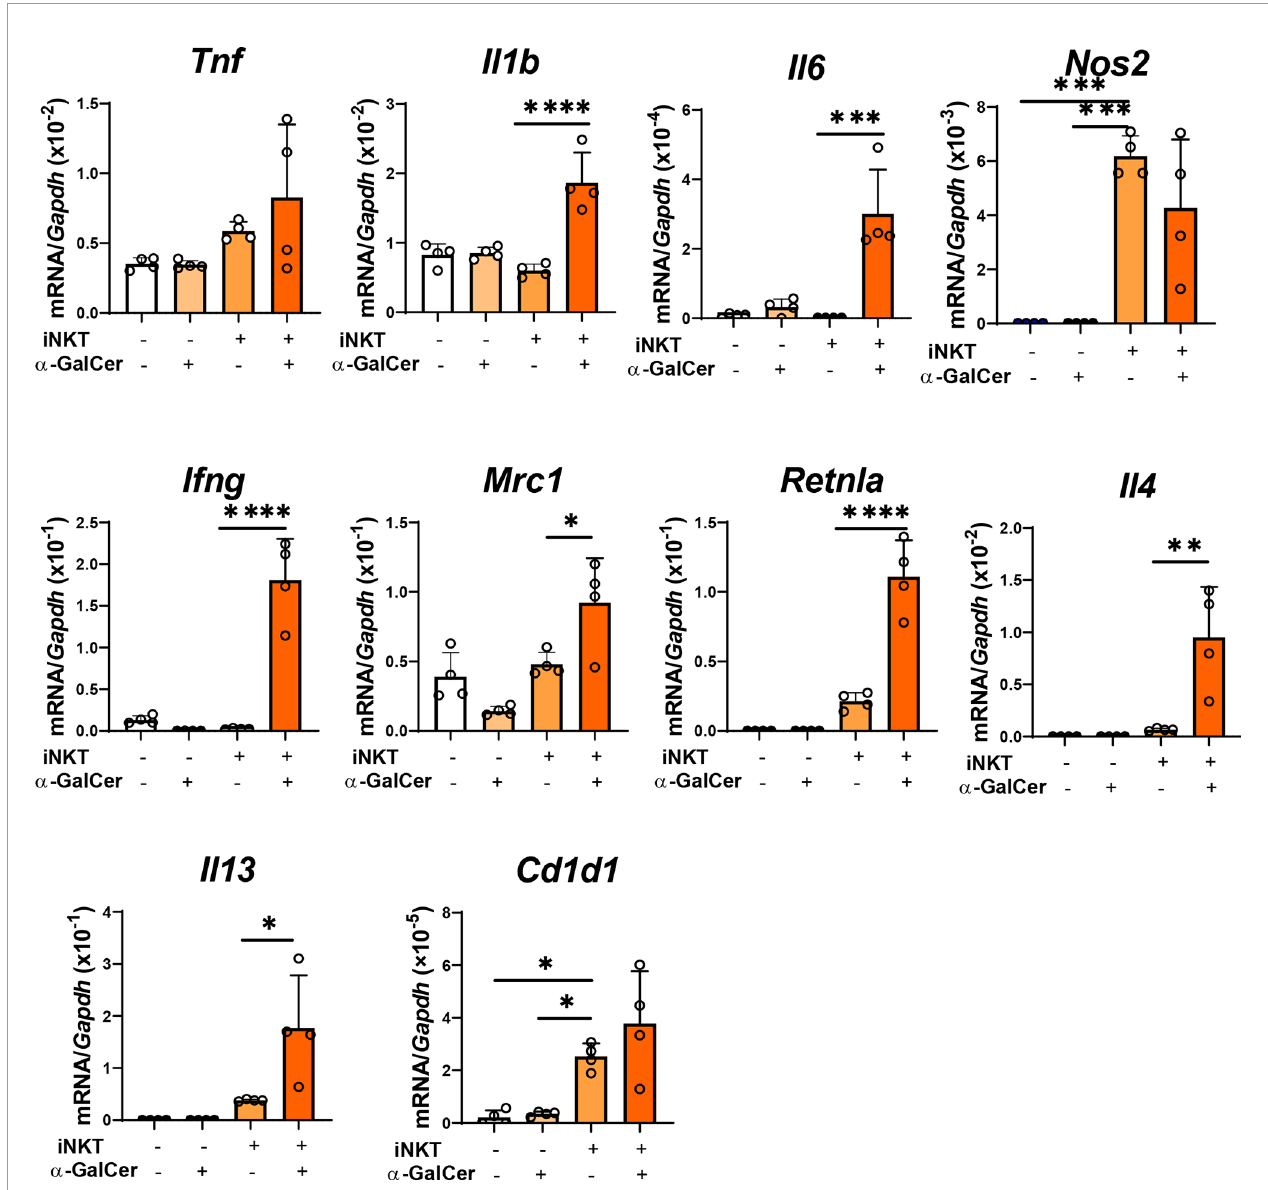
FIGURE 5 | Activated iNKT cells made cultured macrophages differentiate in both ways. The levels of mRNA encoding genes related to a pro-in fl ammatory macrophage phenotype ( Tnf, Il1b, Il6, Nos2, and Ifng ), genes related to a reparative macrophage phenotype ( Mrc1, Retnla, Il4, and Il13 ), and Cd1d in macrophages co-cultured with iNKT cells. Macrophages were cultured alone, in the presence of a -GalCer, or with isolated hepatic iNKT cells, or isolated hepatic iNKT cells and a -GalCer for 72 h. Data are expressed as the mean ± SD (four mice per group, representative data from two independent replicates). * P < 0.05, ** P < 0.01, *** P < 0.001, **** P <